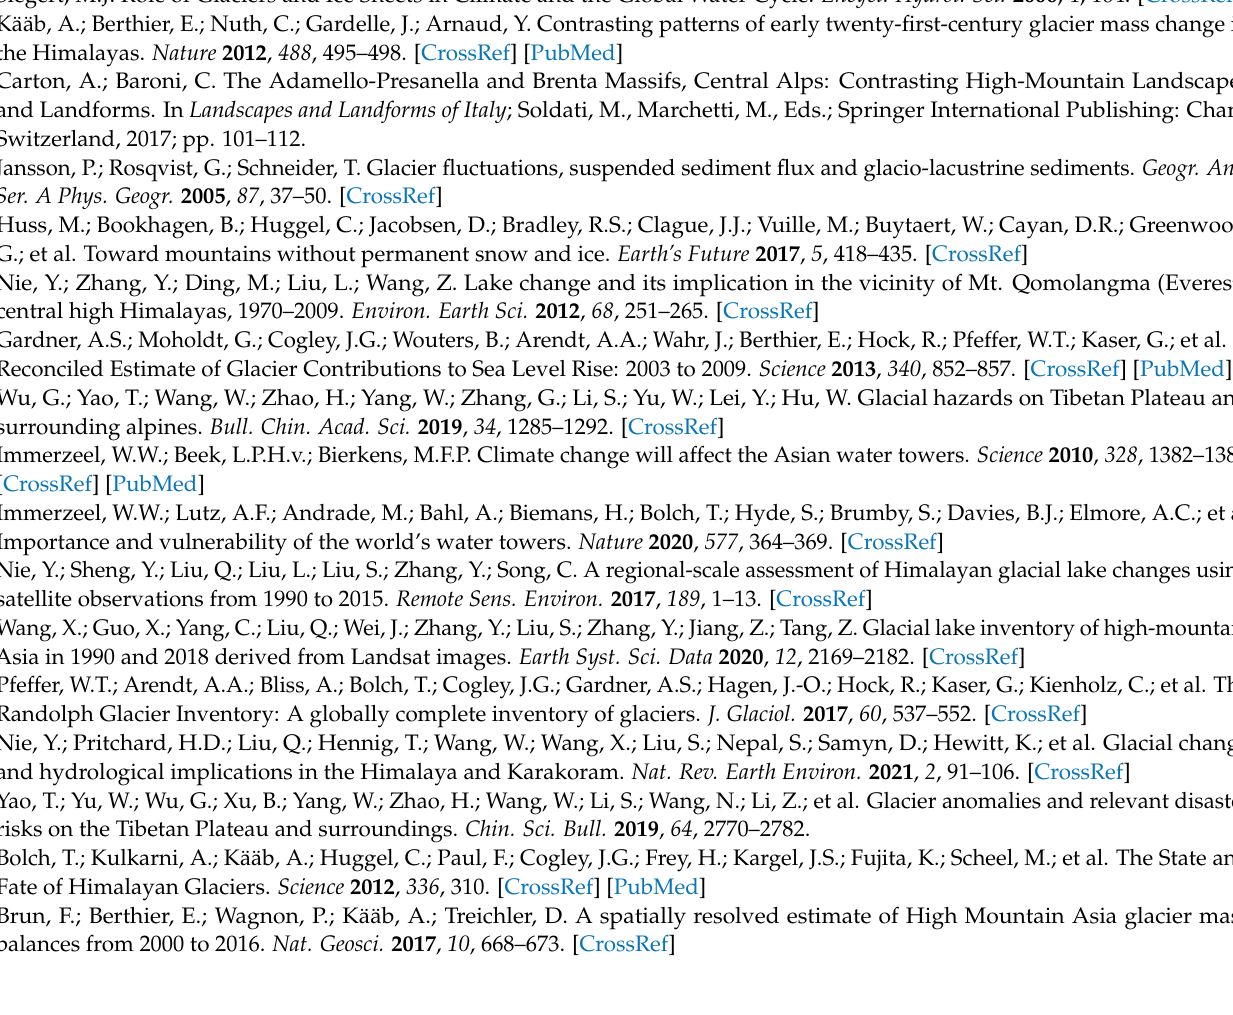
PlanetScope imagery, Figure S3: Supraglacial lakes and ice cliffs on Glacier M base on PlanetScope image, Table S1: Data used for this